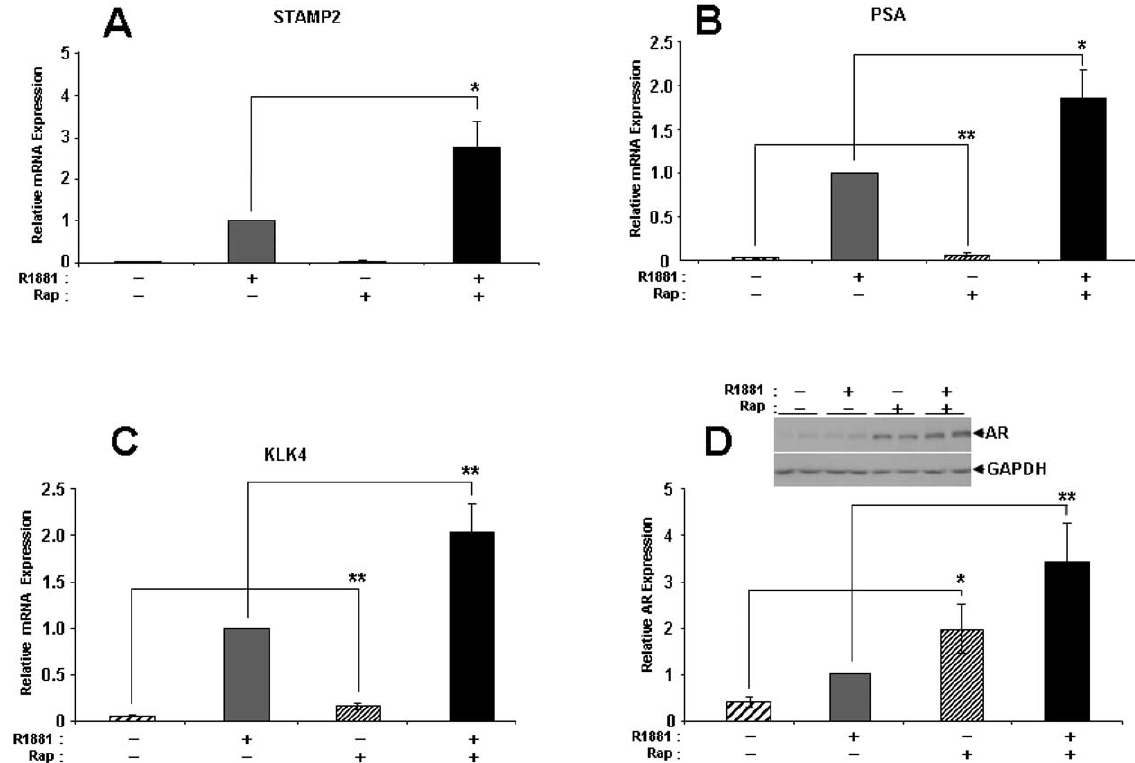
Fig. 2. mTOR inhibition synergizes with androgen to increase expression of AR target genes. (A–C) qPCR was performed on cDNAs made from RNA isolated from LNCaP cells treated with rapamycin (100 nM) in the presence or absence of R1881 (10 − 8 M) for 48 h. Note that the cells were grown in low serum conditions to maximize androgen effects (see Section 2). TBP was used as housekeeping gene, the expression levels are relative to R1881 treated cells (set to 1). Differences in the expression of mRNA levels of STAMP2 (A), PSA (B), and KLK4 (C) were determined. The experiments were performed three times in triplicate, with error bars shown as ± SEM. (D) Western analysis was performed on whole-cell extracts made from cells treated as described above to investigate any changes in AR levels. GAPDH was used as a loading control. A representative Western blot, as well as quantification from two independent experiments done in triplicate, is shown. The expression levels are relative to R1881 treated cells (set to 1). (E) Western analysis were performed on whole-cell extracts made from cells treated with rapamycin (100 nM) in the presence or absence of R1881 (10 − 8 M) for 72 h as indicated. Antibodies against STAMP2, PSA, KLK4 and GAPDH were used sequentially on the same blot. The expression levels were normalized to GAPDH and the values presented are relative to R1881 treated samples (set to 1) (F–H). The differences between the groups were evaluated using one-tailed, paired Student’s t- test compared to non-treated samples, with P < 0 . 05 being considered as significant. Significance is indicated by asterisks, P < 0 . 05 and double asterisk, P < 0 .